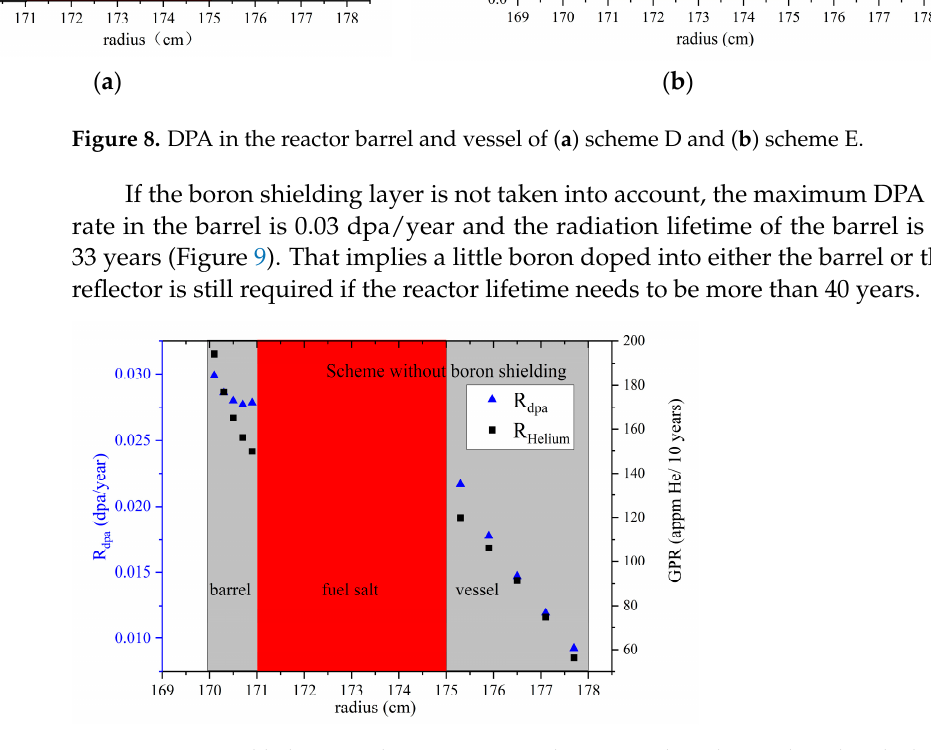
Figure 9. DPA and helium production rates in scheme E without boron doped in the barrel.